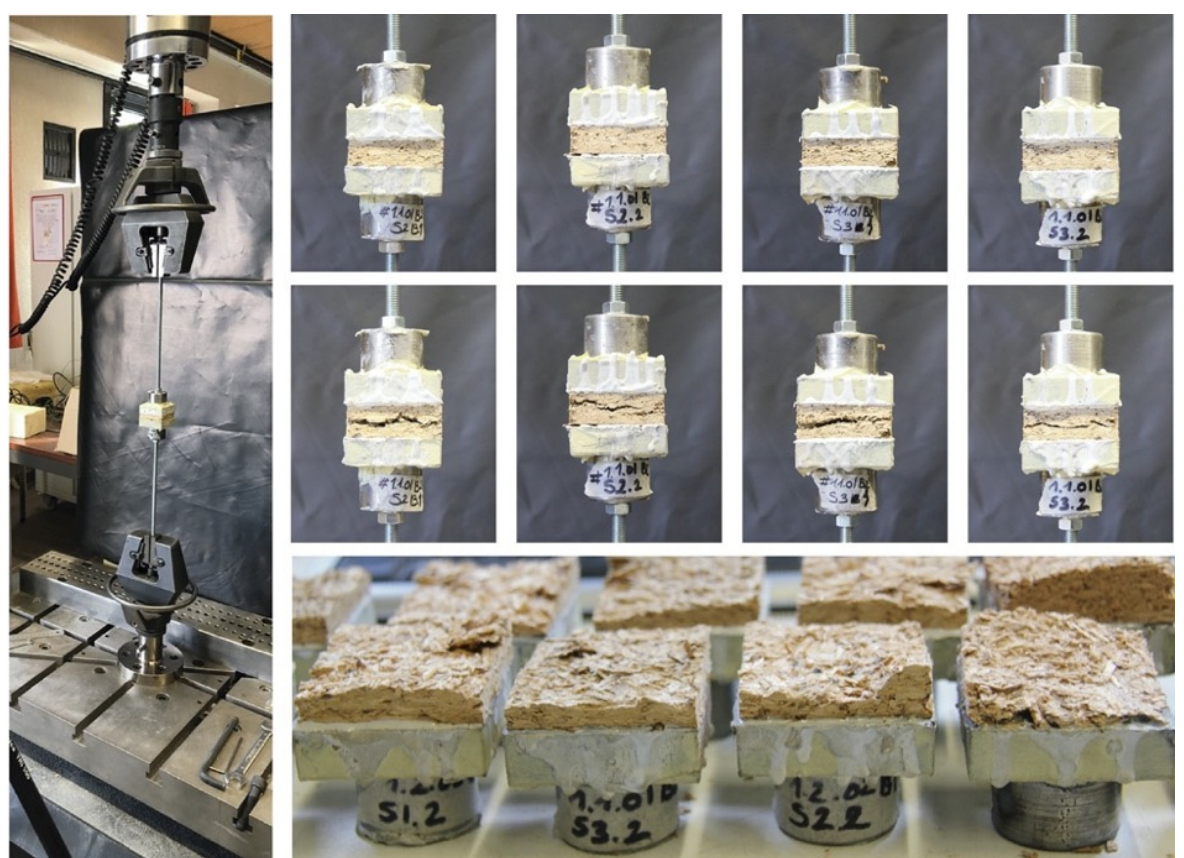
Figure 11. Detail of specimens and fixtures before and after loading for tension tests perpendicular to the surface (internal bond). Table 3. Overview of the material properties in internal bond of nanoclay–mycelium composites. The standard deviation is performed with 9 specimens (mean ± one standard deviation).